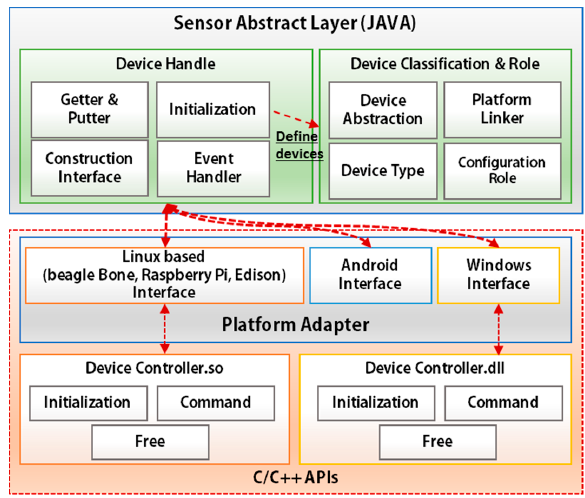
Figure 3. Sensor abstract layer architecture. Table 2. Main interface for hardware device development.